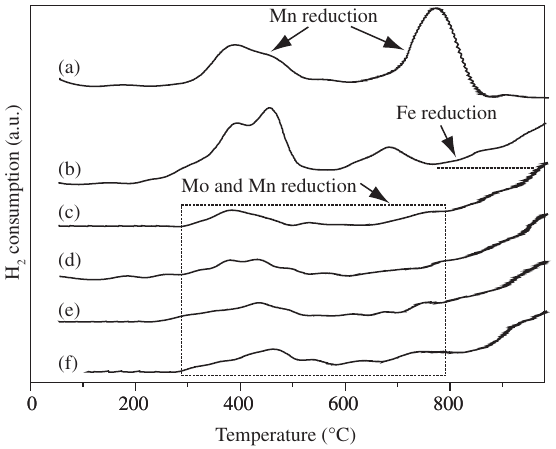
Figure 4. Temperature programmed reduction (TPR) spectra of a) LaMnO b) LaMn LaMn